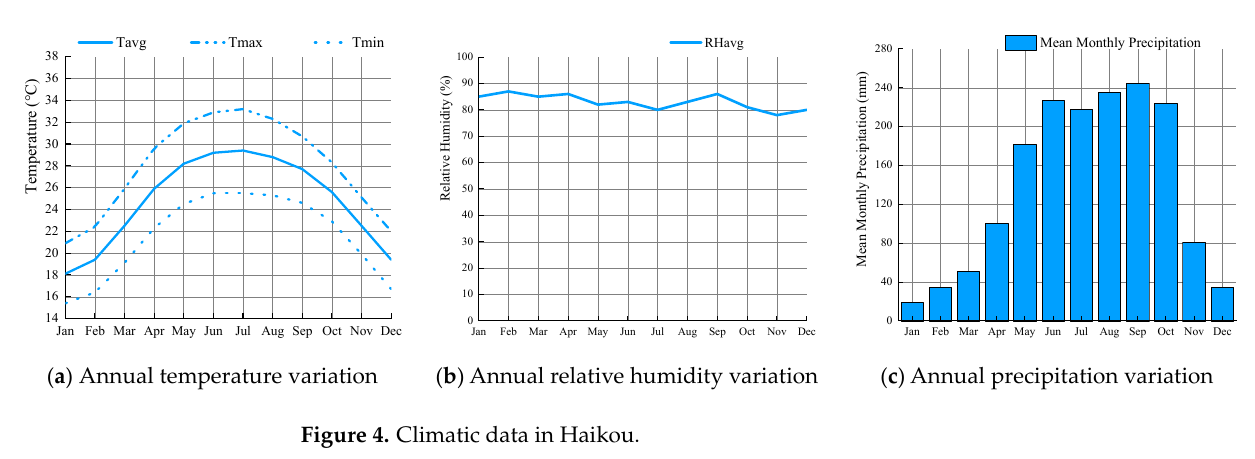
Figure 3. LSH distribution in Hainan Island.